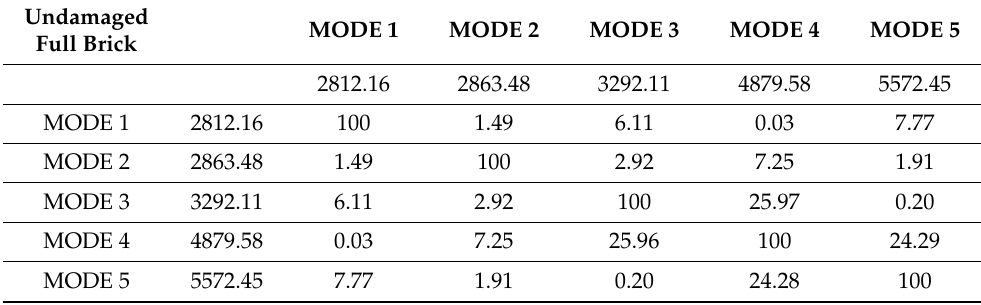
Table 1. The result of the validation (AutoMAC) in tabular form for undamaged solid ceramic brick. Undamaged